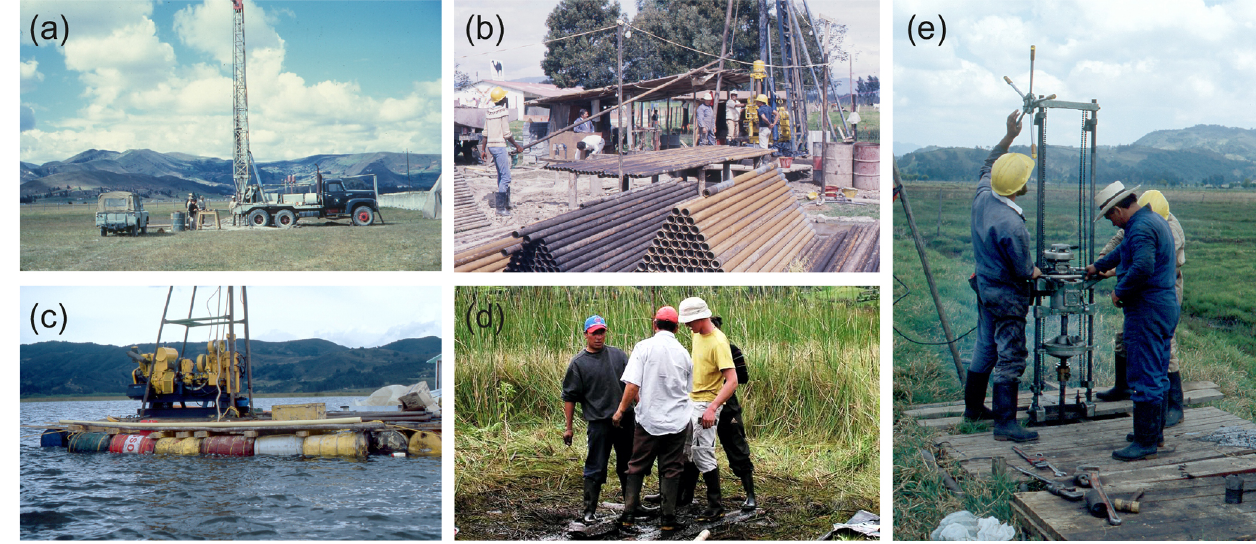
Figure 3. Photographs of the drilling sites at Funza 1 (a) , Funza 2 (b) , Fúquene 4 (c) , La Cocha (d) , and Fúquene 9 and 10 (e)